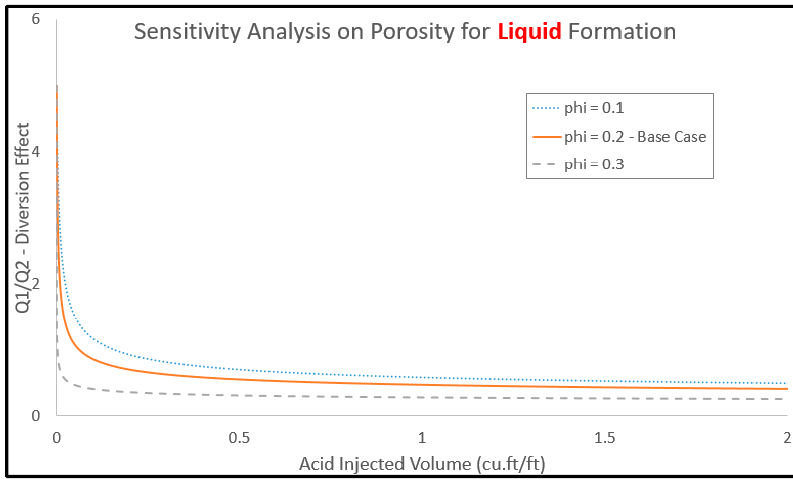
Figure 16. Effect of formation porosity on acid diversion performance. Figure 16. E ff ect of formation porosity on acid diversion